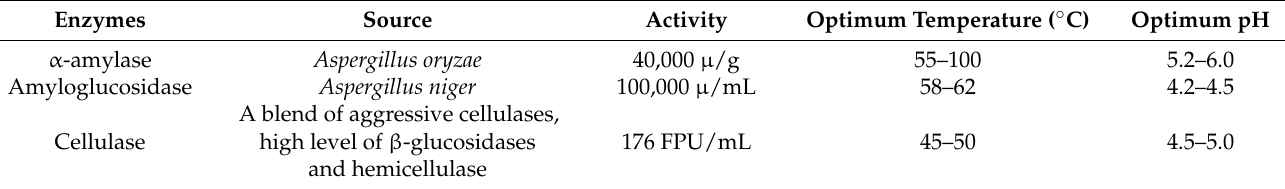
Table 1. Detailed information on the enzymes used in this